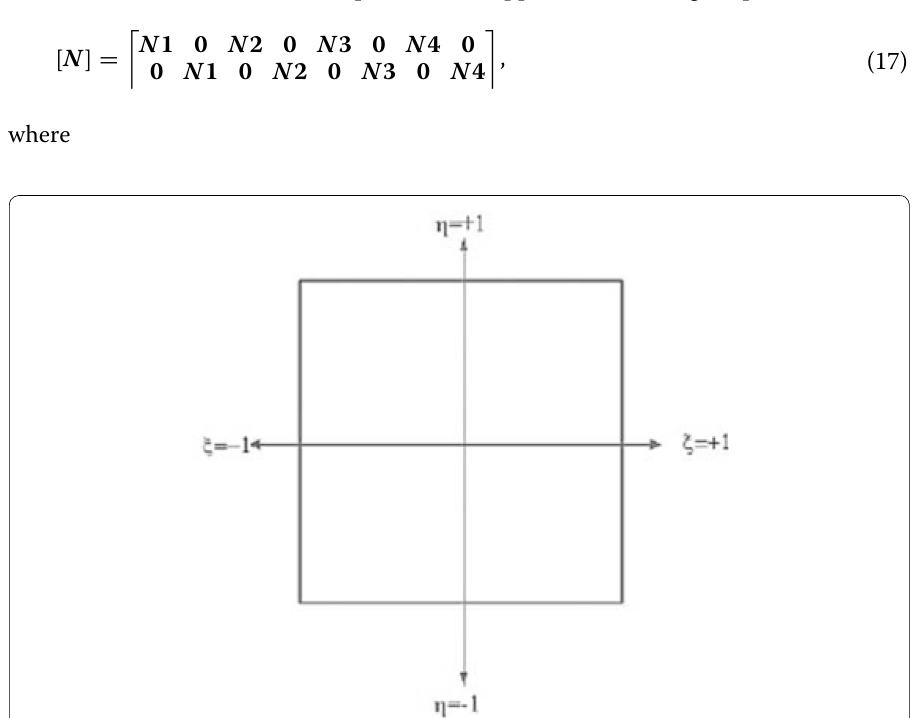
Fig. 5 Square finite element in the Natural coordinate